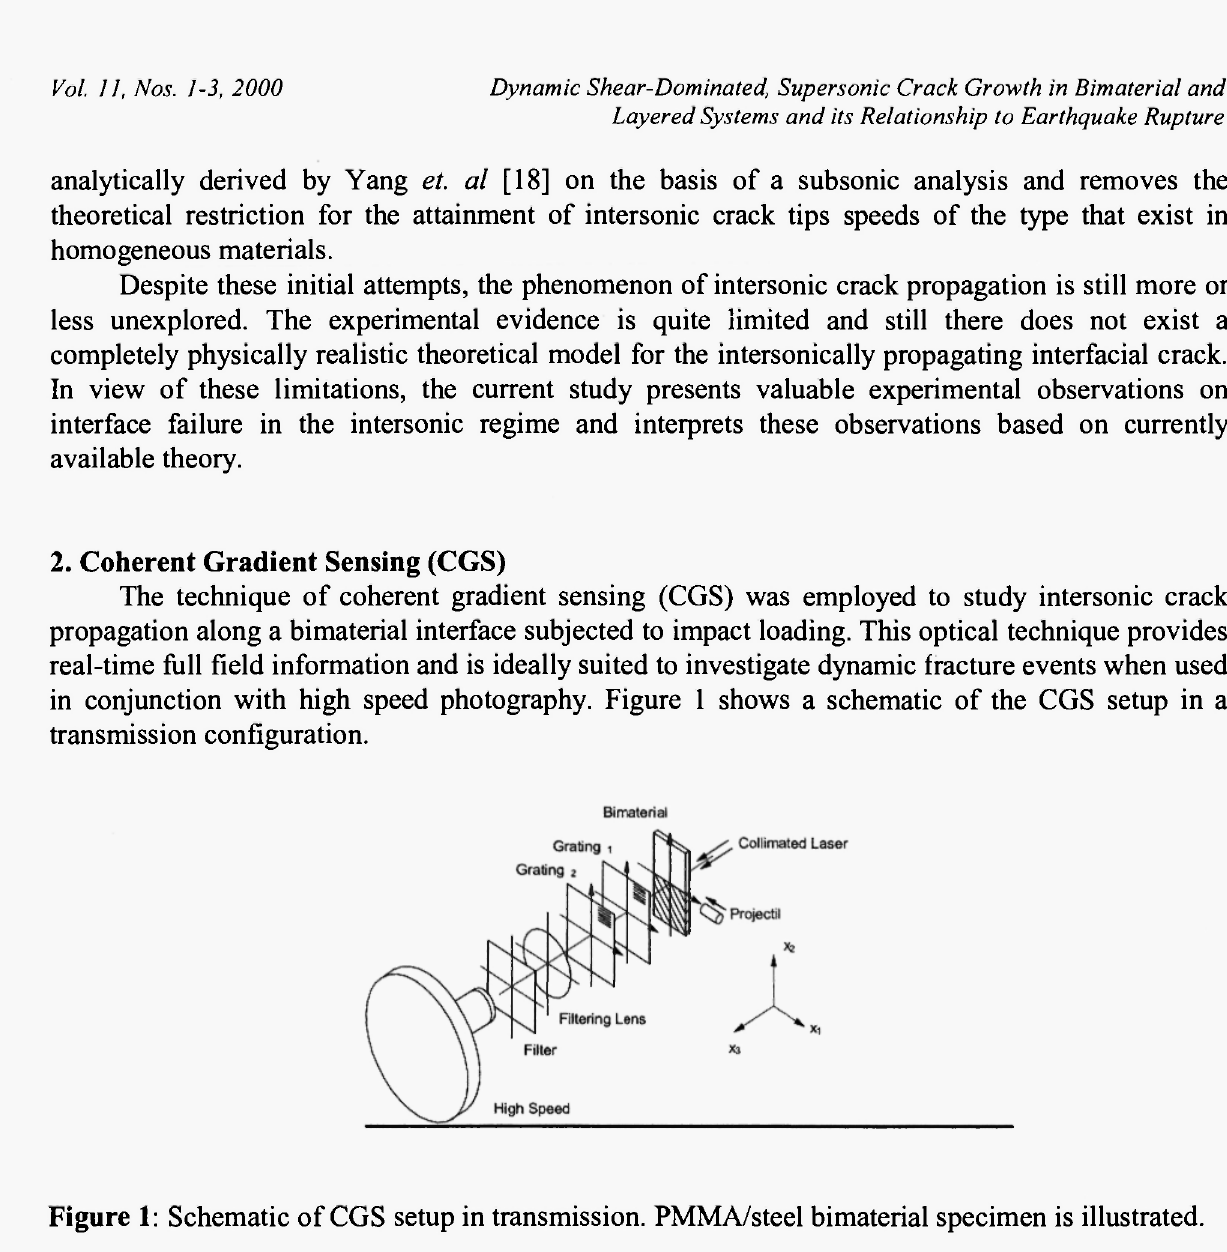
A coherent, monochromatic, collimated laser beam is incident of the bimaterial specimen. After transmission through the transparent side of the deforming specimen, it acquires an optical path difference and loses collimation. The optical path difference acquired is due to stress induced differences in refractive index and due to a non-uniform contraction in the thickness direction around the vicinity of the crack tip (Poisson's ratio effect for elastic solids). The resulting, non- collimated, beam passes through two line diffraction gratings Gi and G2 of fine pitch ρ (typically 40 lines/mm). The gratings are situated a distance ^(typically 30-50 mm) apart and perform a "shearing" of the incident wave front. The gratings' output intensity is transmitted through a filtering lens L. A diffraction spot pattern is obtained on the filtering plane, which is located at the back focal plane of lens L. At this plane all but one diffraction orders are blocked. The one